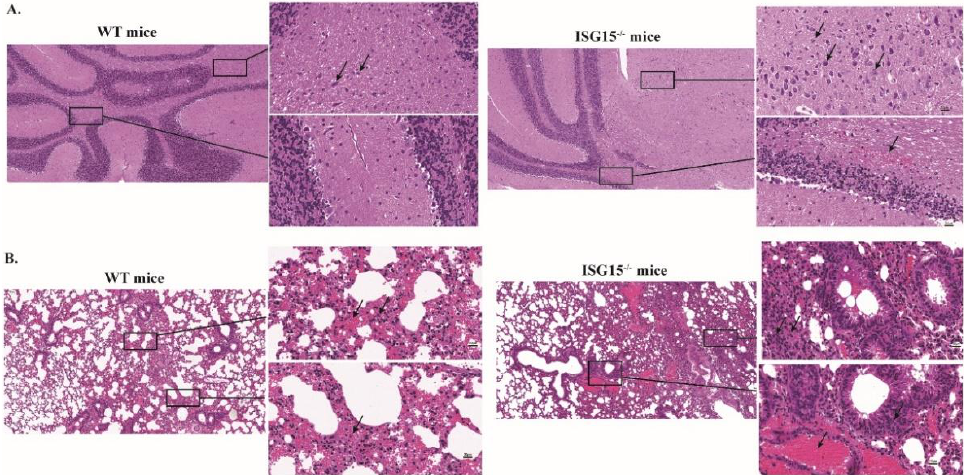
Figure 2. Histopathological examination of brains and lungs of infected ISG15 -/- and WT mice. WT ( n = 10) and ISG15 -/- ( n = 10) mice were intraperitoneally infected with PRV. At 4 dpi, the brains and lungs of infected mice were collected, sectioned and stained with hematoxylin-eosin. Magnified regions are indicated with rectangles in ( A , B ). Scale bar: 100 μ m and 20 μ m.